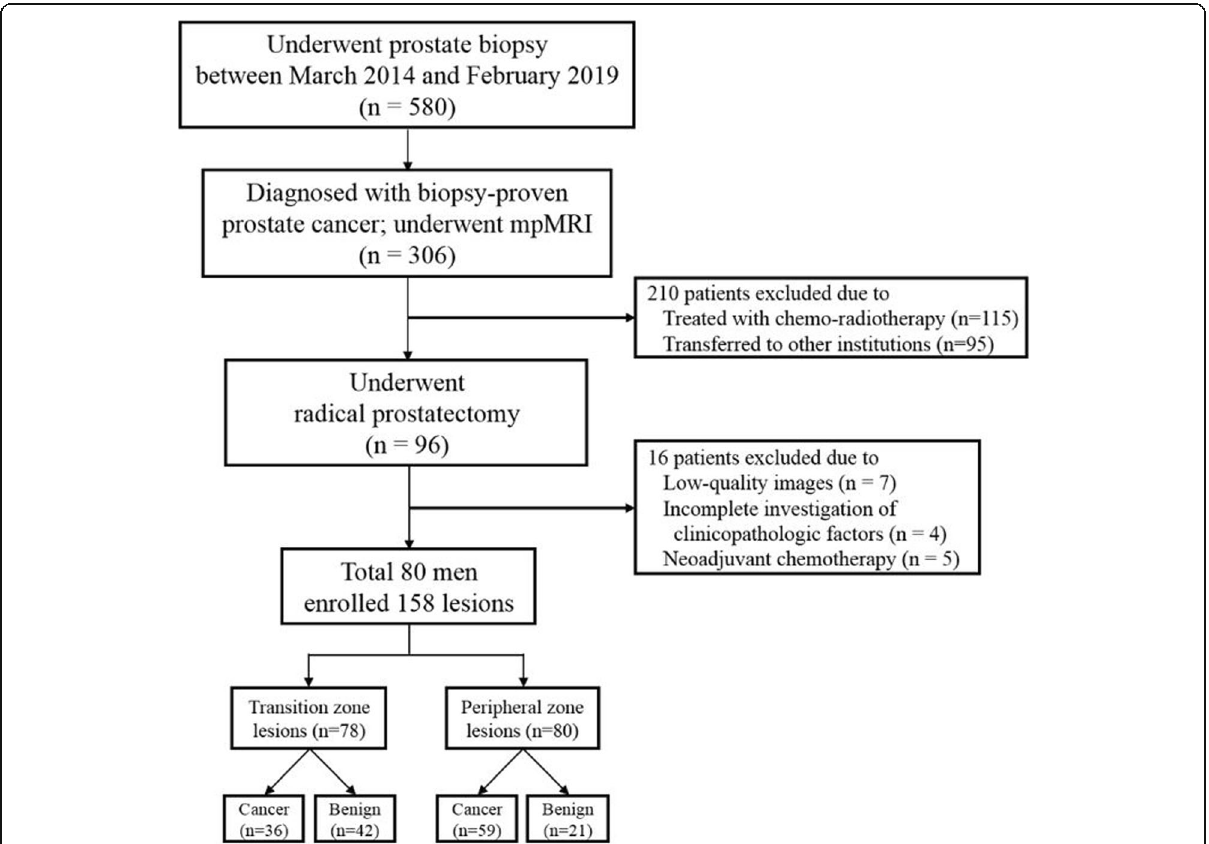
Fig. 1 Flow chart of inclusion